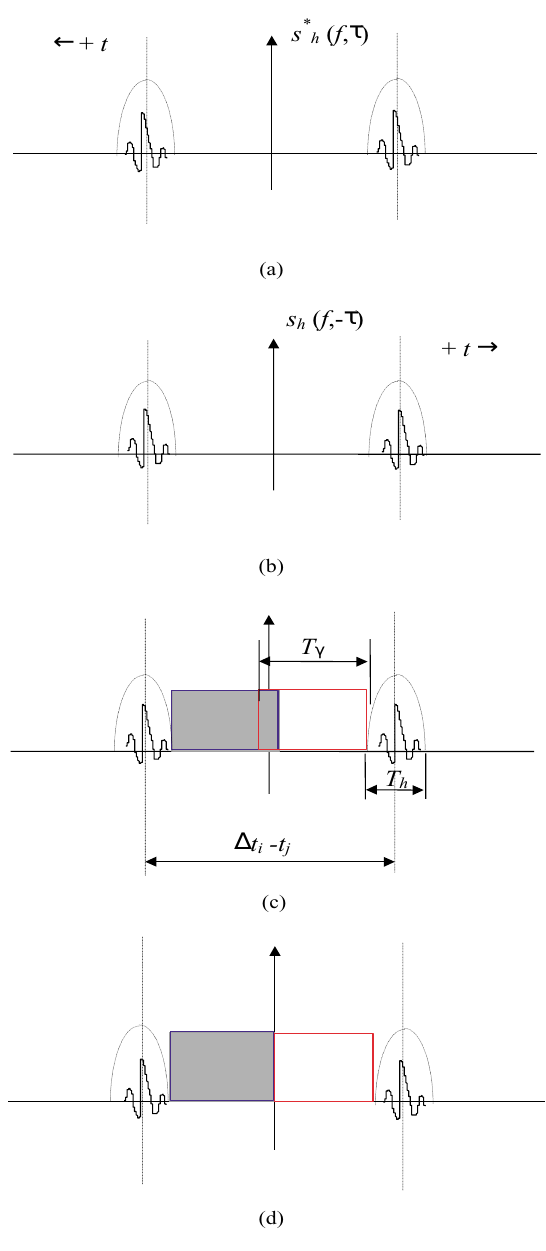
Fig. 1. Illustrating the proper width of the γ ( τ ) window function. (a) convolving signal s ∗ h ( t ) . (b) convolving of signal s h ( t )